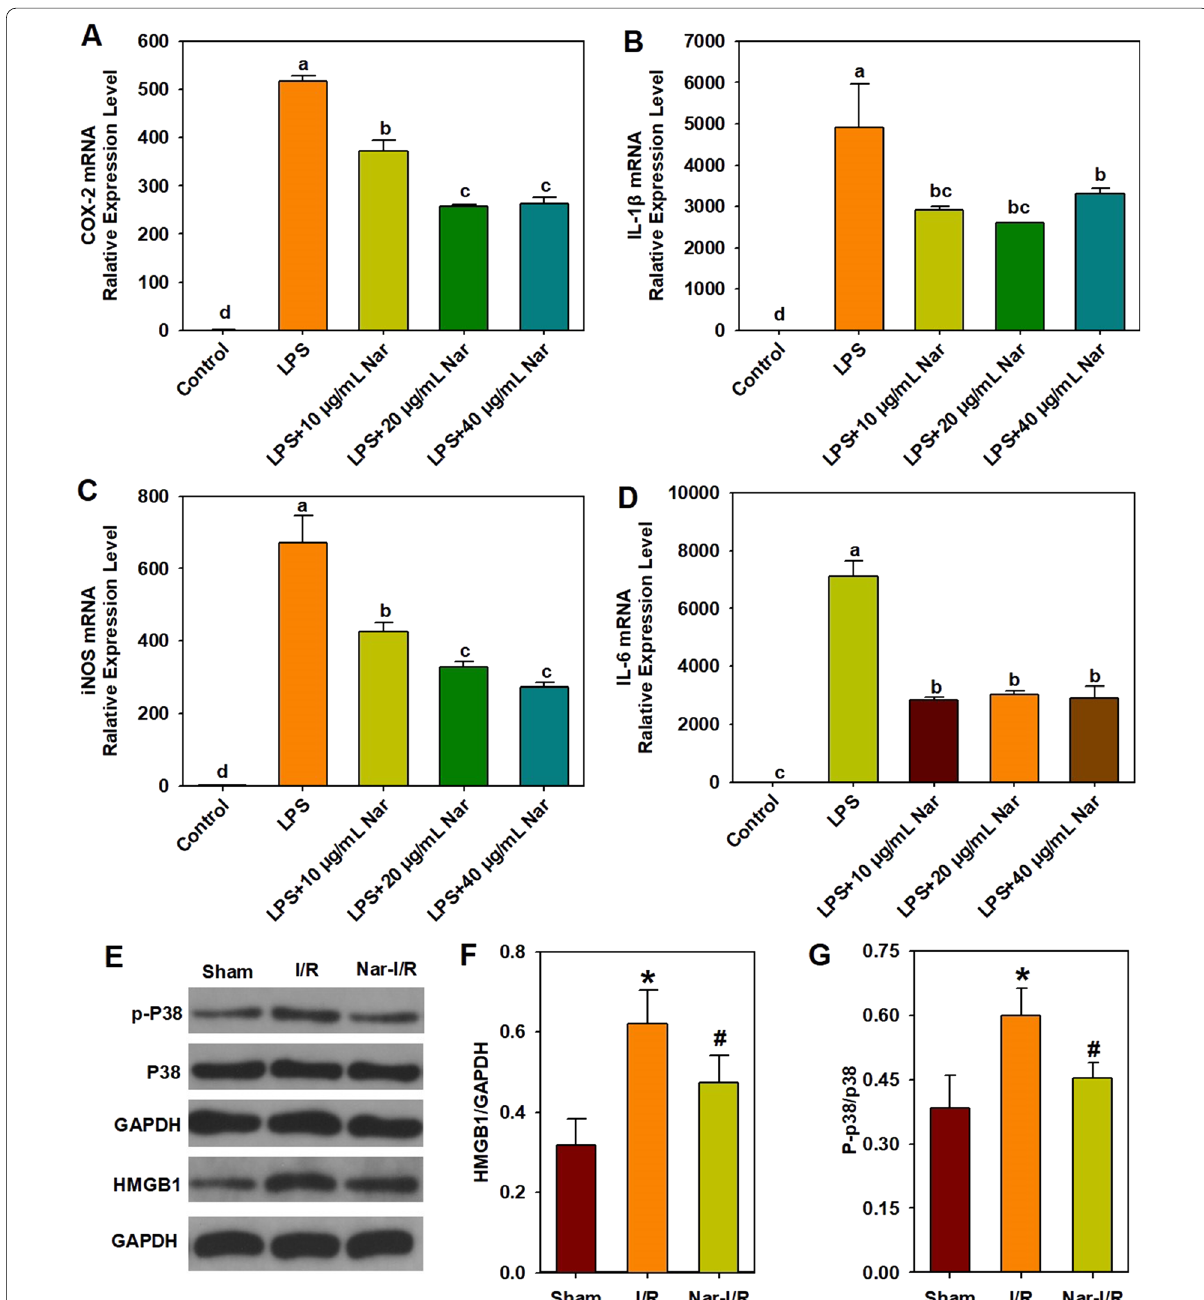
Fig. 3 Anti-inflammation of naringin in vitro and in vivo. A – D Effect of naringin on LPS-induced mRNA expression of COX-2, iNOS, IL-1β, and IL-6 in RAW 264.7 macrophages. The concentration of LPS is 1 μg/mL. A COX-2 mRNA relative expression level; B IL-1β mRNA relative expression level; C iNOS mRNA relative expression level; D IL-6 mRNA relative expression level. Different letters show significant differences ( p < 0.05). E – G Anti-inflammation effect of naringin on myocardial ischemia/reperfusion injury in rats. E Representative images of the Western blot results. F HMGB1 protein Expression level; G p-P38 protein expression levels. * p < 0.05 vs. the Sham group; # p < 0.05 vs. the I/R group. COX-2, cyclooxygenase-2; HMGB1, high mobility group box 1 protein; IL-1β, interleukin-1β; IL-6, interleukin 6; iNOS, inducible nitric oxide synthase; I/R, ischemia/reperfusion; LPS, lipopolysaccharide; Nar,